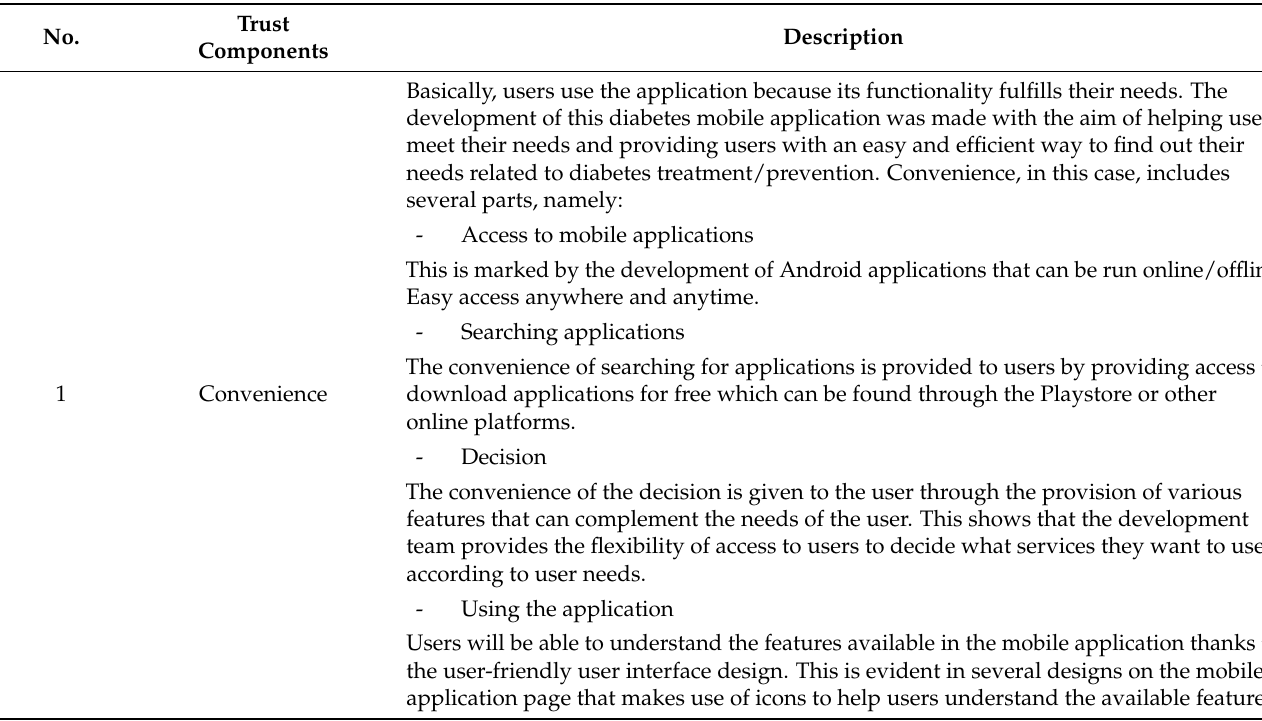
Table 9. Trust Components in Mobile Application